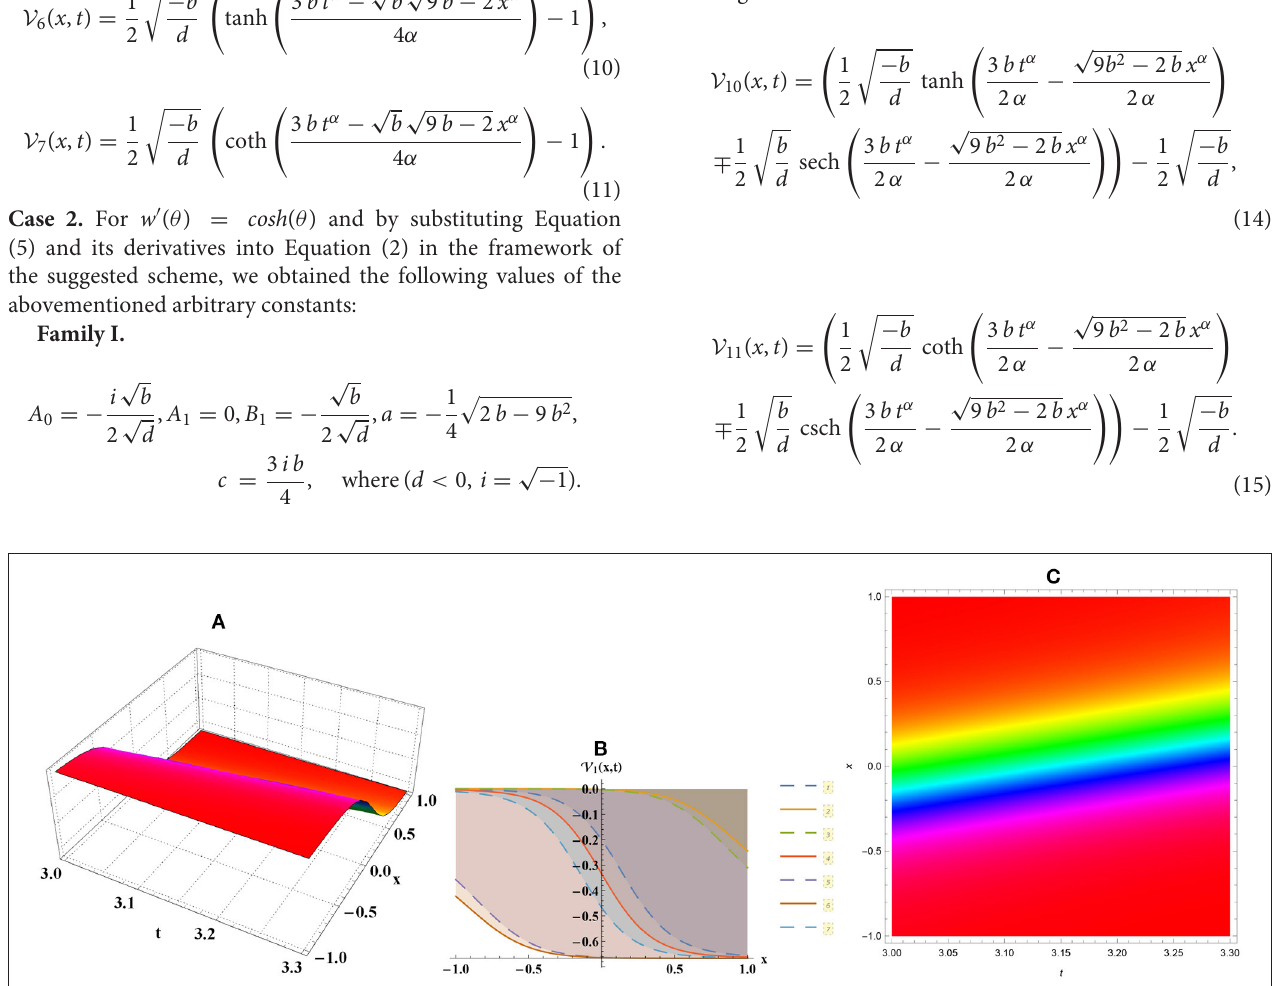
FIGURE 1 | Kink numerical graph for Equation (4) through (A) three-dimensional, (B) two-dimensional, and (C) density plots.